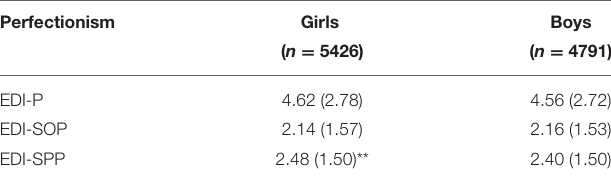
TABLE 1 | Perfectionism scores split by Gender presented as Means (SD) n .